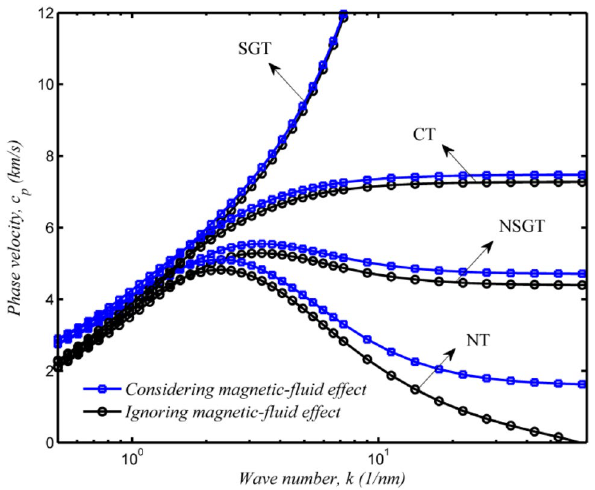
Fig. 5 The phase velocity in terms of the Knudsen number for = 0.19nm , ea = 0.3 nm and various k = 10 ( 1 ∕ nm ) , Kn = 0 .001, l m fluid velocity